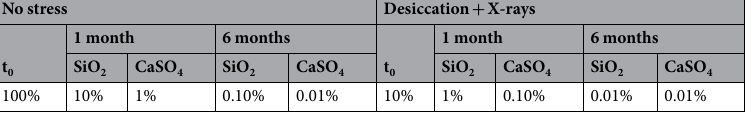
Table 1. Viability of Yersinia populations, exposed or not to a preliminary stress, after 1 and 6 months of mineralization, either in silica or in gypsum.